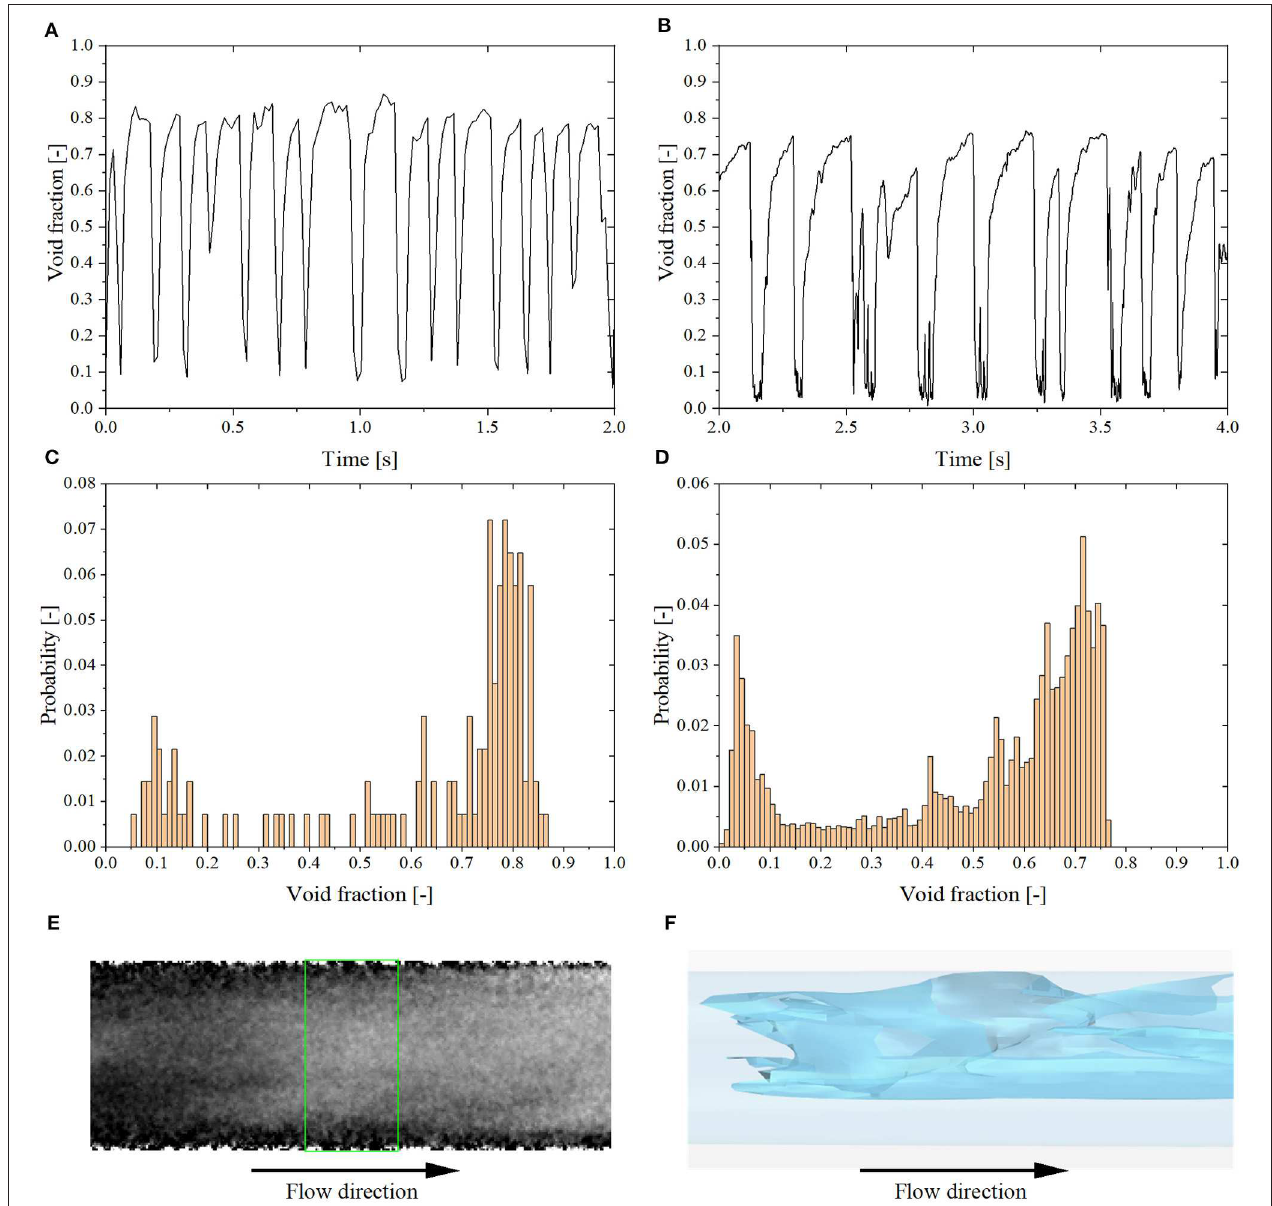
FIGURE 9 | Results of test No. 7. (A) Experimental void fraction time evolution. (B) Simulation void fraction time evolution. (C) Experimental void fraction histogram. (D) Simulation void fraction histogram. (E) X-ray void fraction contrast image. (F) Void fraction isosurface